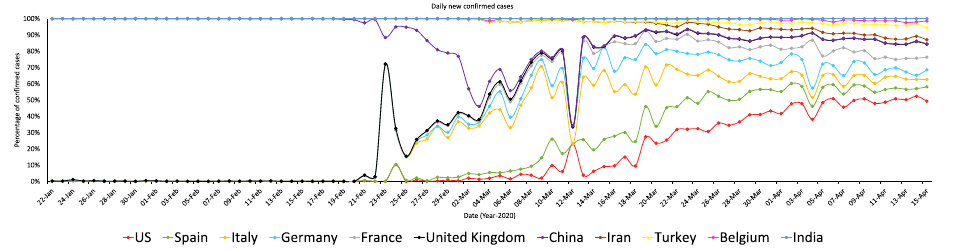
Fig. 2. Daily confirmed cases of top-10 countries in the world and